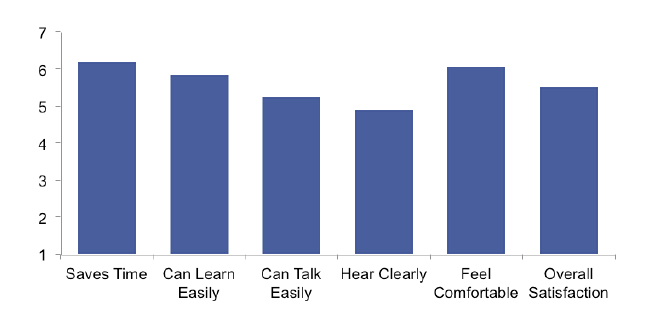
Figure 3. TUQ means for selected questions of interest in phase 2. Note: Higher scores indicate higher levels of usability and